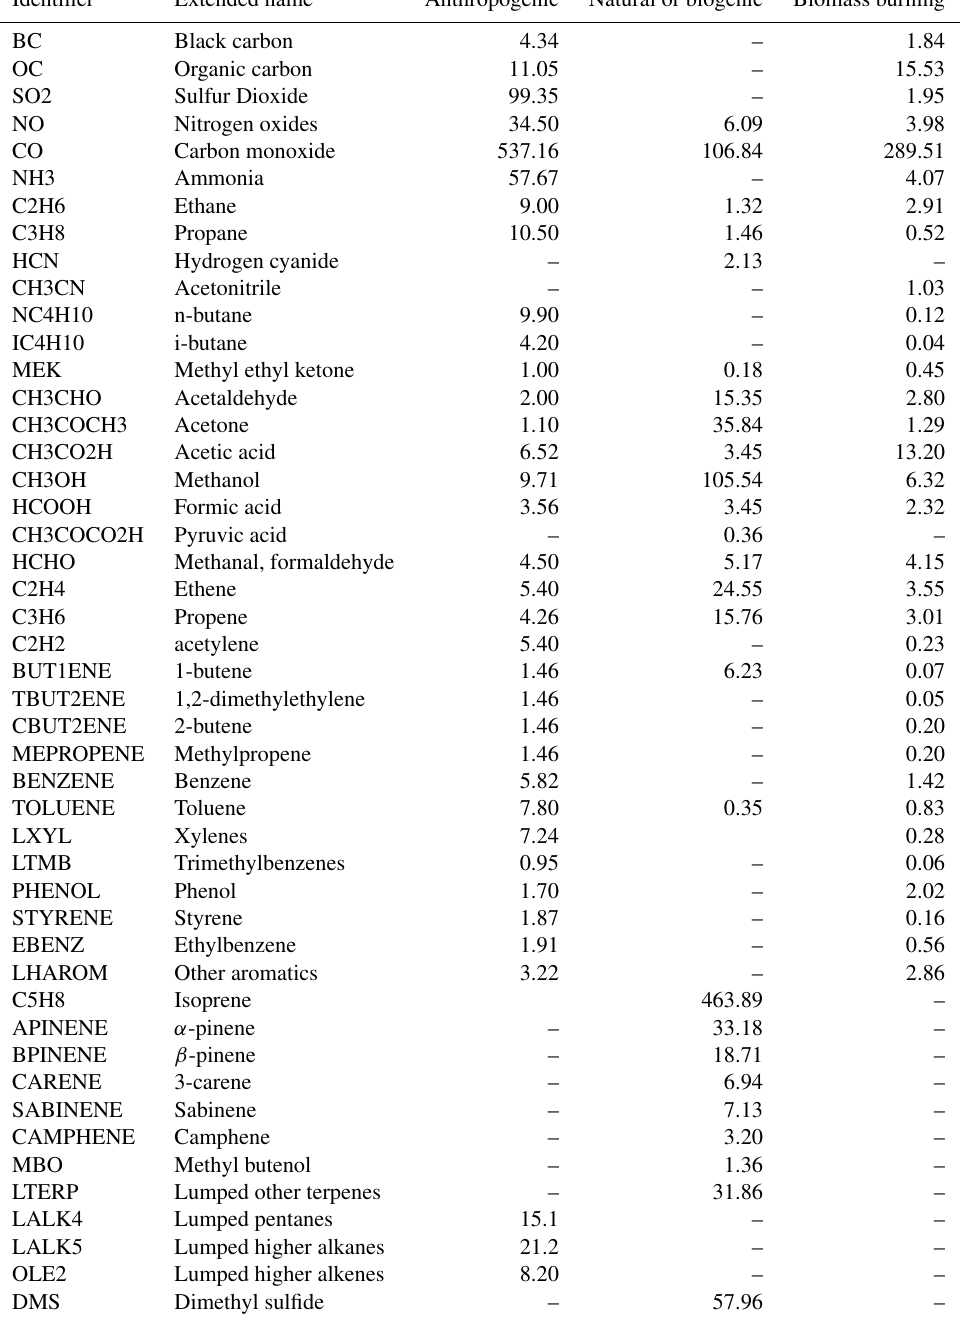
Table 1. Emissions of primary emitted species for the year 2010 used in this study. The values are given in units of Tg ( species ) yr − 1 with the exception of NO, which is given in Tg ( N ) yr − 1